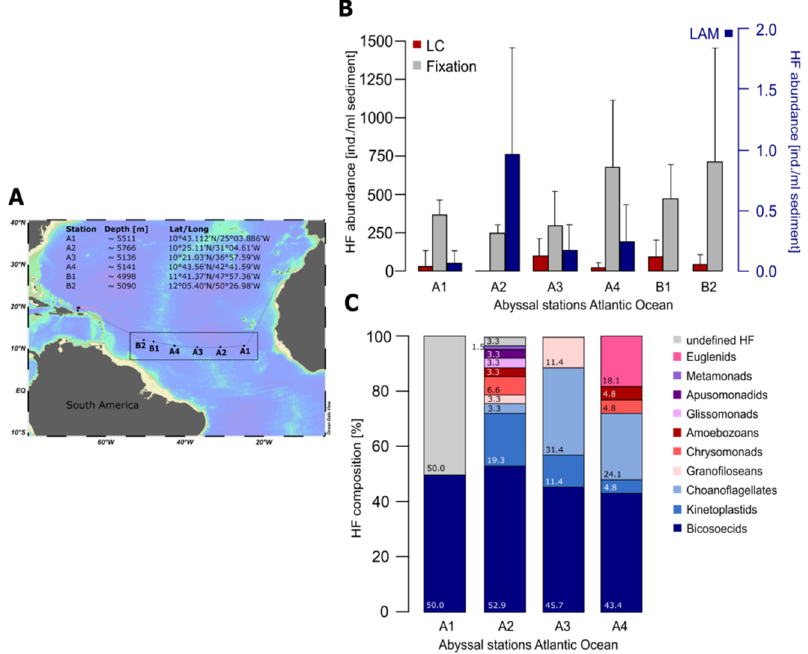
Figure 2. Comparison of methods applied for investigations of deep ‐ sea heterotrophic flagellates in the VEMA fracture zone, southern North Atlantic. ( A ) Station map (created with Ocean Data View [37]) of the research cruise with R/V Sonne II (SO 237, 14.12.2014–26.01.2015). Sampling stations are indicated by black dots and station labelling (A1–A4, B1, B2). ( B ) Mean heterotrophic flagellates (HF)